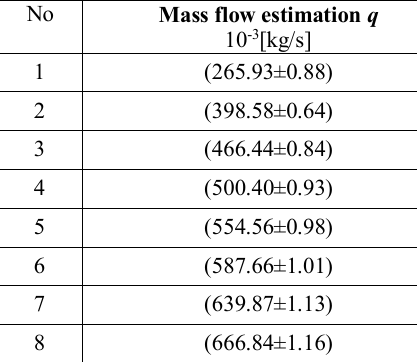
Table 3 . The results of mass flow estimation from Monte Carlo